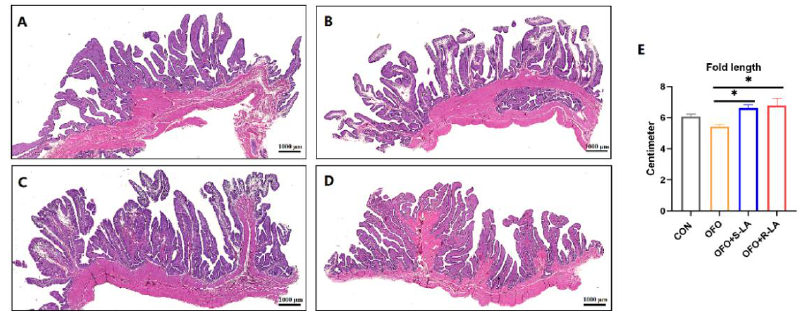
Figure 6. Effect of different treatments on oviduct structure of laying hens. ( A ) CON group; ( B ) OFO group; ( C ) OFO + S-LA group; ( D ) OFO + R-LA group; ( E ) fold length in different treatments. * Indicates minimum significant differences ( p < 0.05). Graphs were observed at 0.5 × , the size unit of the photograph is 1000 µ m.